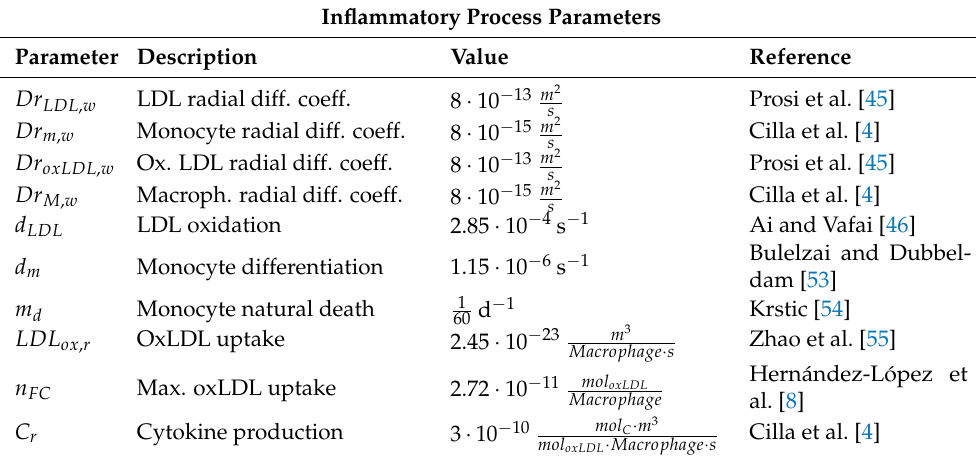
Table 3. Parameters to calculate the inflammatory process in the arterial wall. Inflammatory Process